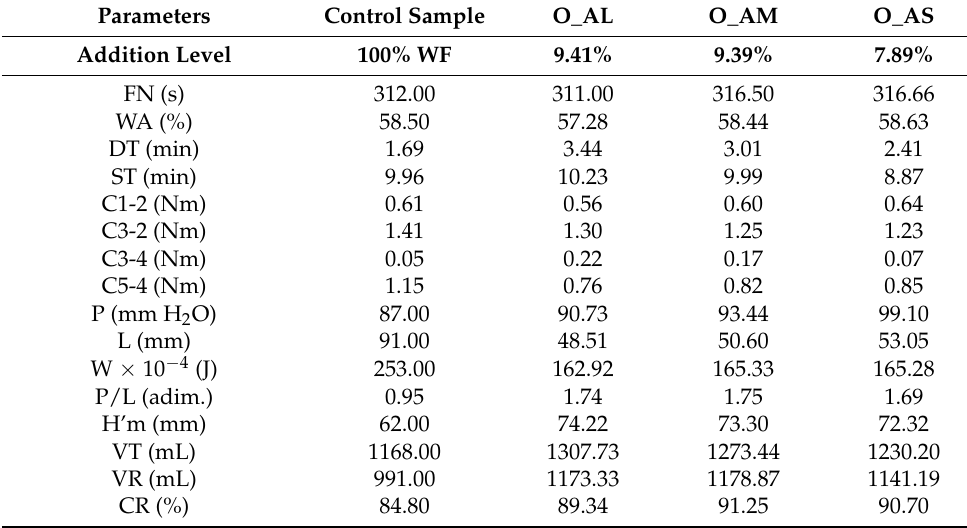
Table 5. Wheat flour dough and optimized composite flour for each amaranth flour particle